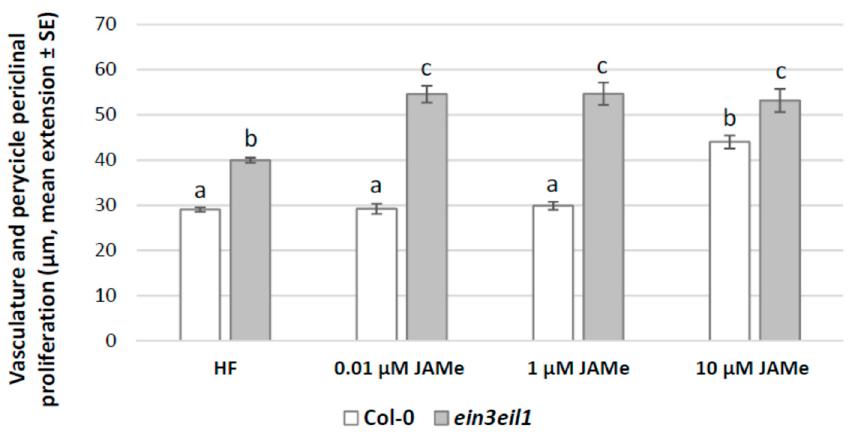
Figure 1. Pericycle periclinal proliferation in the basal hypocotyl of Arabidopsis Col-0 (wt) and ein3eil1 double mutant seedlings either cultured with different JAMe concentrations (0.01, 1, 10 μ M) or in hormone-free (HF) condition. Mean radial extension (± Standard error (SE)) of the vasculature and the pericycle periclinal proliferation in the basal 5 mm of the hypocotyl. Different letters among different treatments within the same genotype, or between the two genotypes within the same treatment, indicate significant differences at least at p < 0.001. The same letters indicate no significant difference. Two-way ANOVA followed by Tukey’s post-test. n = 30.